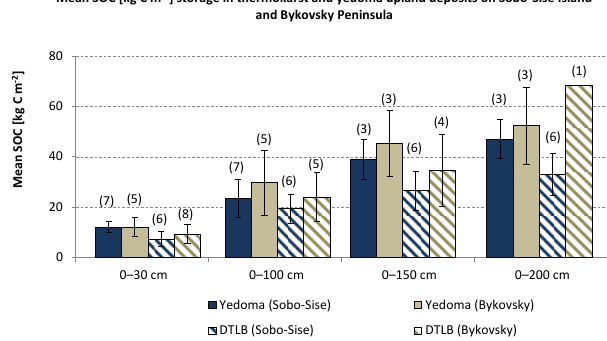
Figure 3. Comparison of mean sampling site SOC storage on Sobo- Sise Island and on Bykovsky Peninsula. Solid bars: yedoma sites, striped bars: thermokarst sites. Black T-lines show the standard de- viation, and number in brackets indicates the number of sampled sites. Profiles shorter than 200cm were extrapolated to the next ref- erence depth. When an ice wedge was reached at a collected site, this was included in the extrapolation as well, assuming no carbon for ice wedge layers. SOC data for this graph are presented in the supplementary material, Tables S1 and S4.